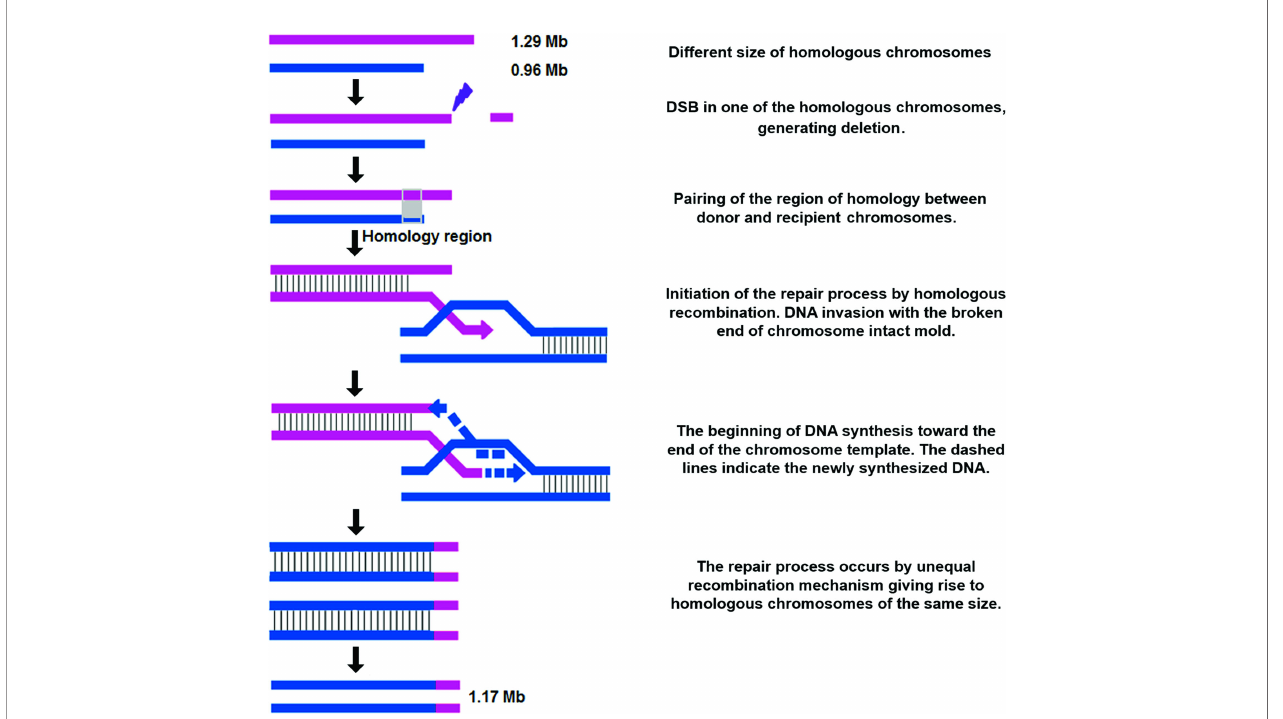
FIGURE 6 | Unequal homologous recombination via break-induced replication (BIR). Possible mechanism of homologous recombination that gives rise to TcChr 22 polymorphism in D11